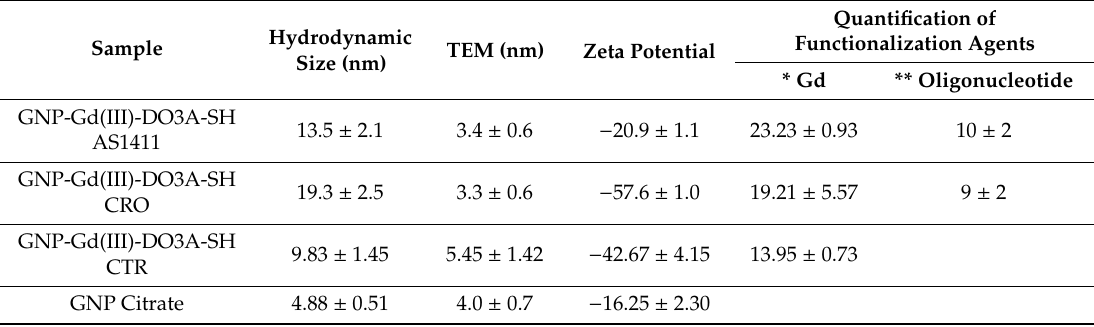
Table 1. Dynamic light scattering (DLS), TEM, and zeta potential characterization of citrate capped GNP and GNP Gd(III) DO3A-SH oligonucleotide and quantification of the functionalization agents Gd(III)-DO3A-SH and AS1411 /